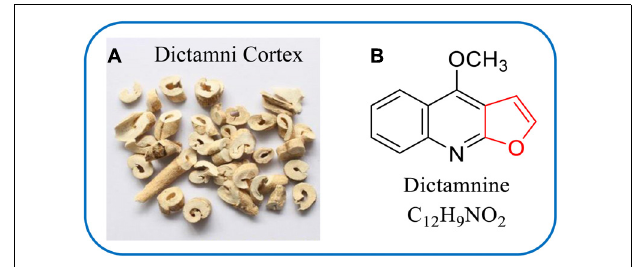
FIGURE 1 | Dictamni Cortex (A) and chemical structure of dictamnin (DTN) (B)